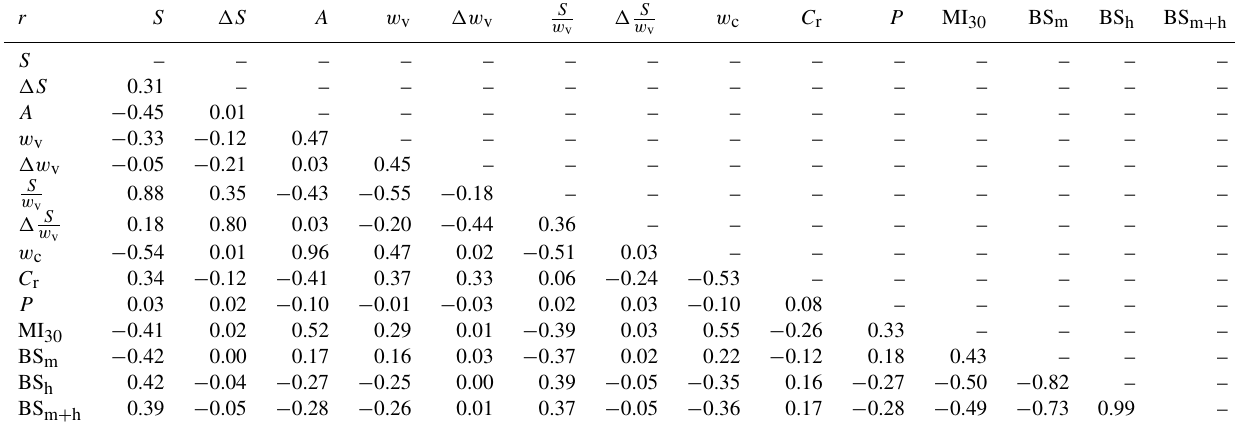
Table A2. Pearson correlation coefficients ( r ) for the independent variables used in our statistical analysis in Hill Gulch. Independent variables include channel slope ( S ), (cid:49)S , contributing area ( A ), valley width ( w v ), change in valley width ( (cid:49)w v ), slope / width ratio ( S change in slope / width ratio ( (cid:49) S ), channel width ( w c ), confinement ratio ( C r ), total precipitation ( P ), maximum 30min intensity ( MI 30 ), w v percent burned at moderate severity (BS m ), percent burned at high severity (BS h ), and percent burned at moderate-to-high severity (BS m + h